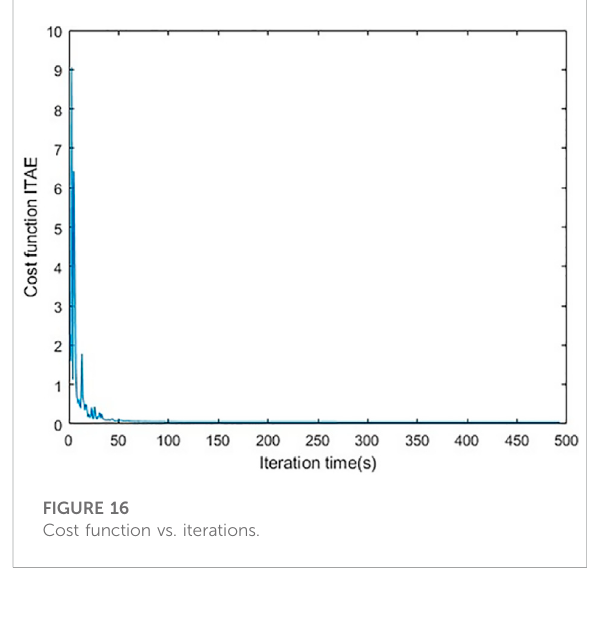
FIGURE 16 Cost function vs. iterations.